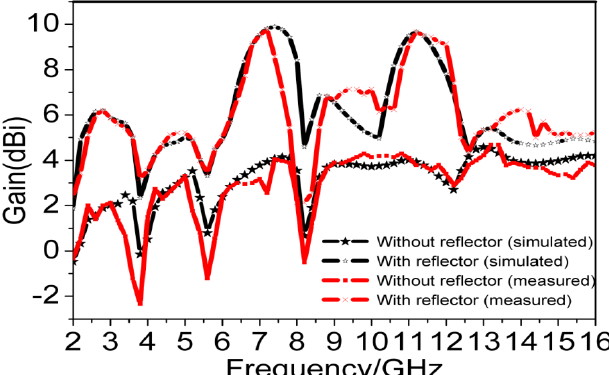
Figure 13: Measured/Simulated Gain curve with frequency with and without reflector of proposed Antenna